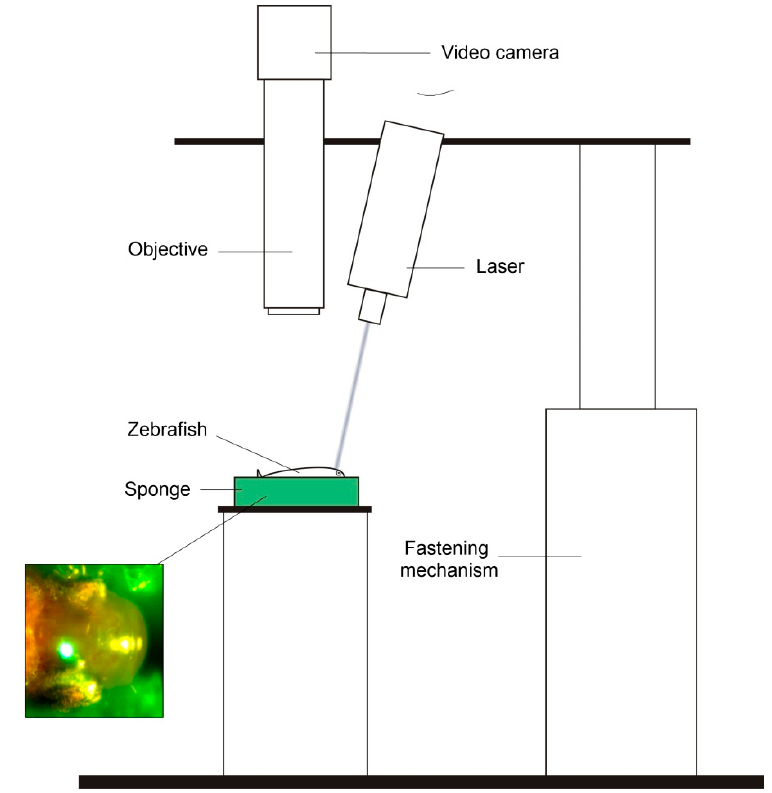
Figure 1. Laser set-up for precise targeted focused radiation